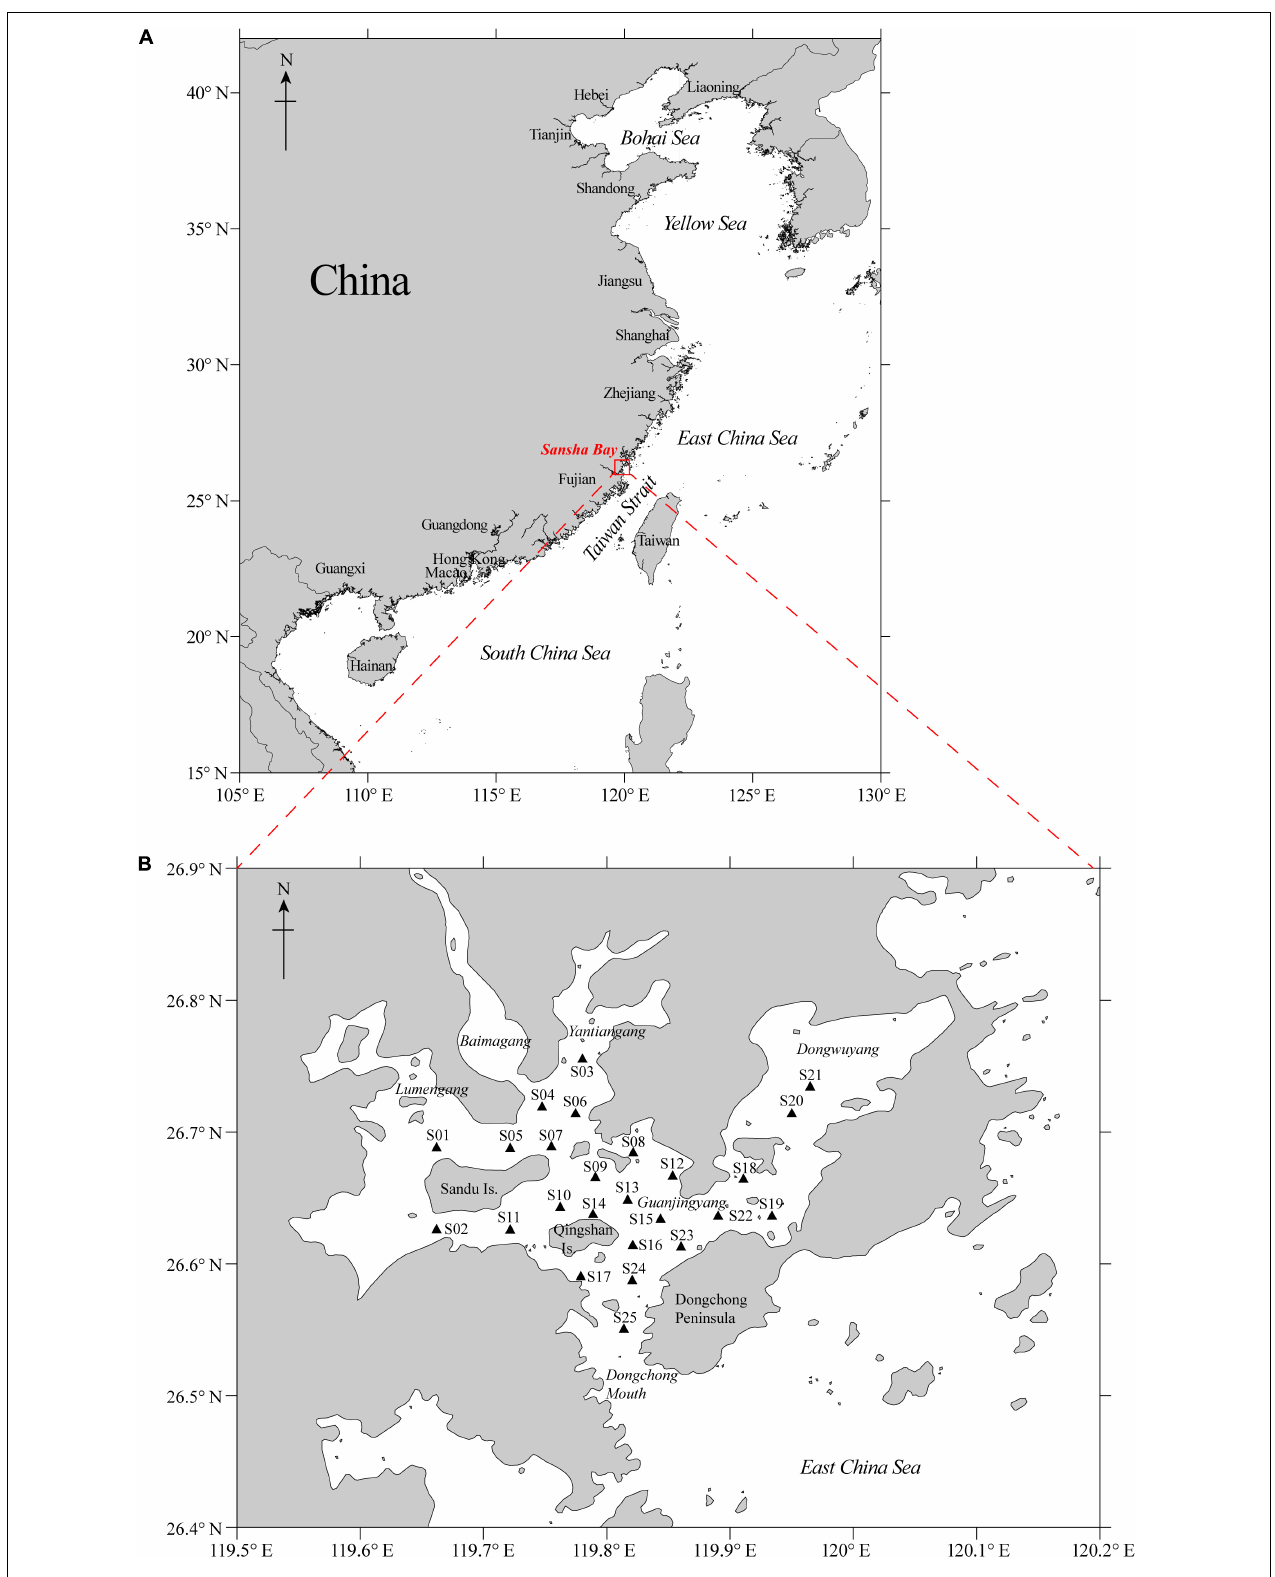
FIGURE 1 | (A) Map of mainland China and (B) ichthyoplankton sampling stations ( n = 25) in Sansha Bay, Fujian Province, China.